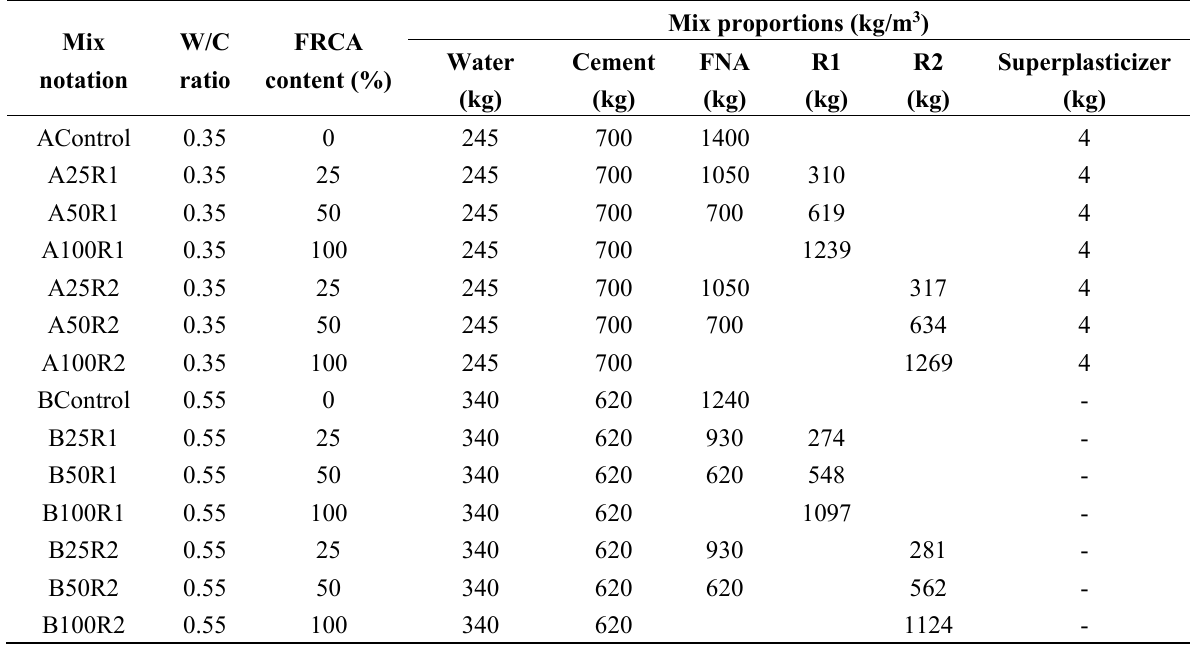
Table 2. Mix proportions of mortar